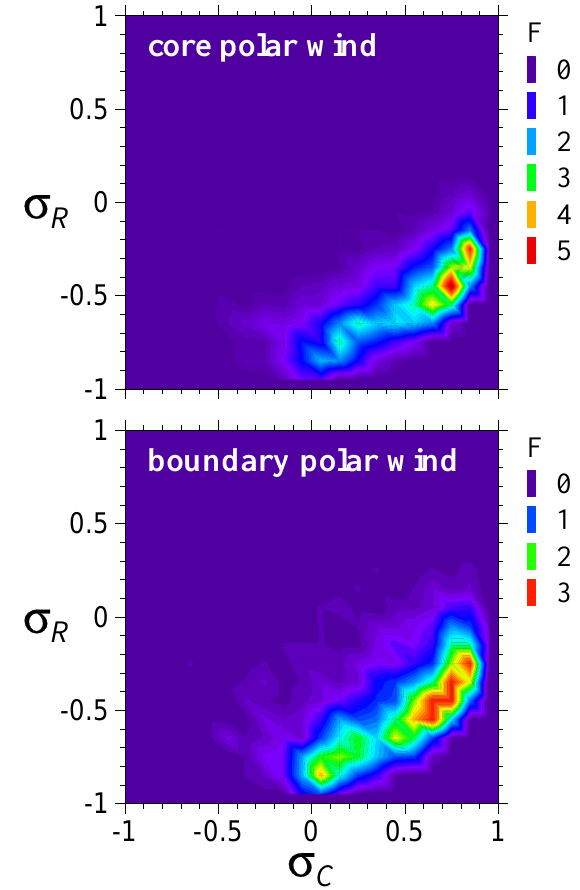
Fig. 1. Distribution of the occurrence frequency F (in per cent) in the plane σ C - σ R for core (top) and boundary (bottom) polar wind intervals. Note that the scale for F is different in the two panels.